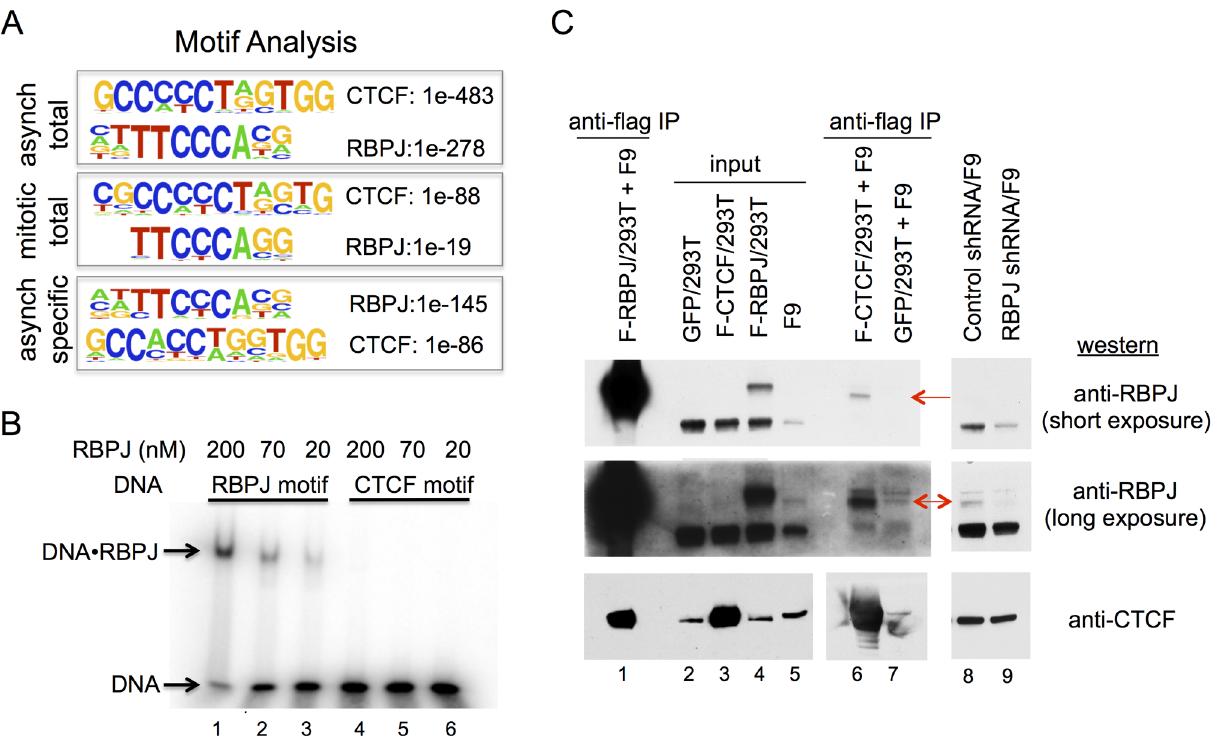
Figure 5. RBPJ interacts with CTCF and is enriched at genomic loci containing CTCF-binding motifs. (A) Protein-binding motifs enriched at sites of RBPJ occupancy on chromatin from asynchronous cells and mitotic cells, as well as occupancy sites unique to asynchronous cells. The enrichment p-values for each motif are as shown. No significant motif was enriched at sites of RBPJ occupancy specific to mitotic chromatin. (B) Electrophoretic mobility shift assays showing binding of RBPJ to DNA containing an RBPJ-binding motif but not to DNA containing a CTCF-binding motif. 16 bp DNA fragments were used at 1 nM and RBPJ protein concentrations are as indicated. (C) Protein interaction experiments revealing RBPJ and CTCF association. Lysates prepared from 293T cells expressing Flag-RBPJ, Flag-CTCF or GFP were incubated with anti-Flag M2 agarose beads ( a - Flag). After protein binding, the beads were washed and then incubated with F9 cell lysate. Bound proteins were eluted with Laemmli buffer and resolved in a NuPAGE 7% Tris-acetate gel (lanes 1, 6 and 7). RBPJ and CTCF were detected by western blot analysis, using antibodies indicated to the right. For the CTCF western, lanes 1–5 were from a long exposure and lanes 6–7 were from a short exposure. Lanes 2 and 5 are input lysates. Lanes 8 and 9 are lysates prepared from F9 cells expressing a control shRNA or an shRNA targeting RBPJ, revealing the presence of different RBPJ isoforms in F9 cells. CTCF was used as a loading control. Arrows point to the low abundance RBPJ isoform.